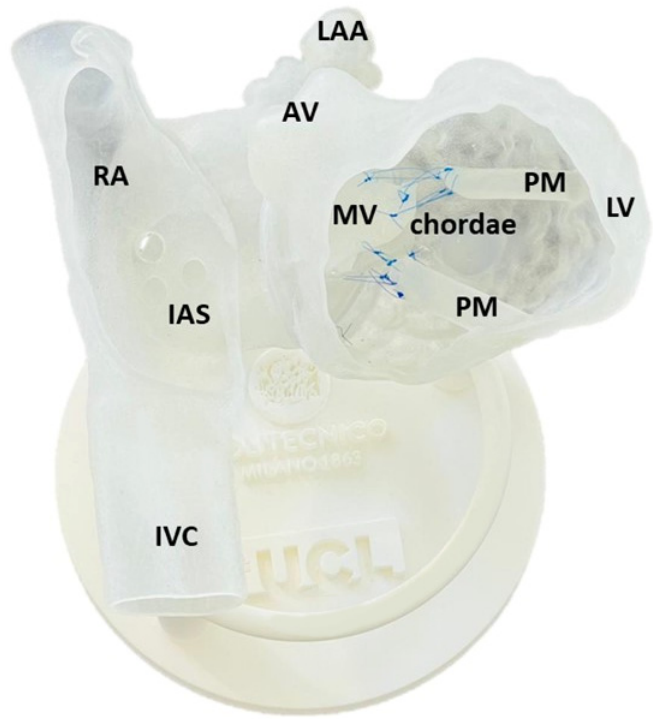
Figure 4. The 3D printed simulator assembled to practice a mock intervention of TEER. Labels indicate the main anatomical features: aortic valve (AV), chordae, interatrial septum (IAS), inferior vena cava (IVC), left atrial appendage (LAA), left ventricle (LV), mitral valve (MV), papillary muscles (PM), and right atrium (RA).